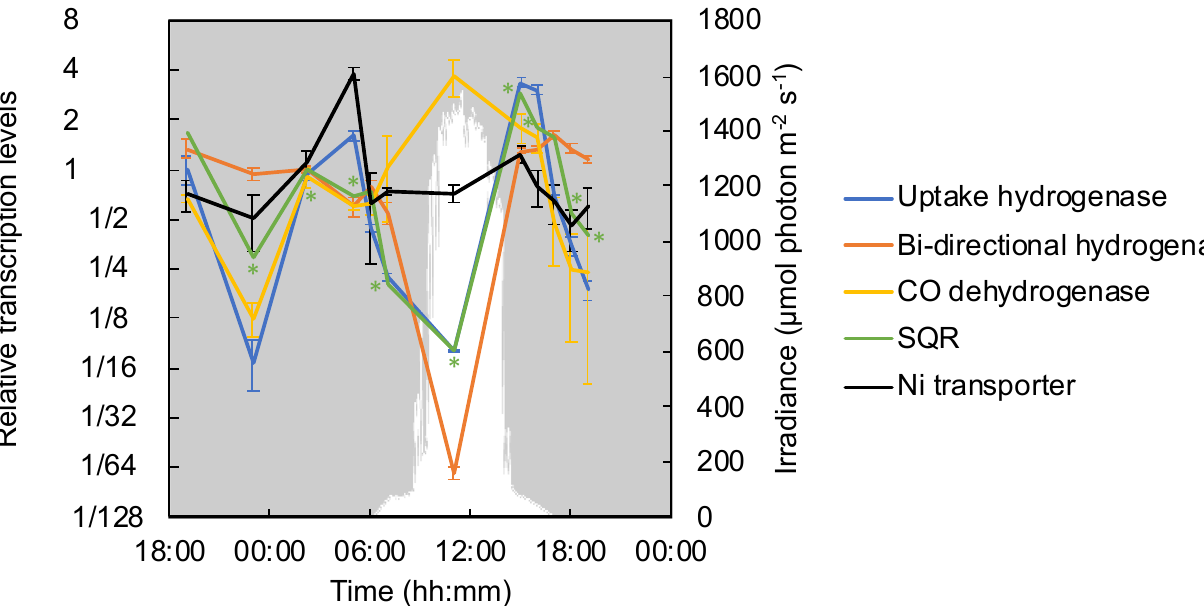
Figure 7. Relative transcription levels of genes encoding hydrogenases, sulfide:quinone oxidoreductase and nickel transporter in cyanobacterial mats. The mean values of the relative transcription levels for type-I uptake Ni-Fe hydrogenase genes hydAB (Cagg_0470–0471, blue line), bi-directional Ni-Fe hydrogenase genes homologous to frhA , frhG , hoxU , nuoF and hoxE (Cagg_2476–2480, orange line), carbon monoxide (CO) dehydrogenase genes coxGSML (Cagg_0971–0974, gray line), and nickel transporter genes (Cagg_1273–1276, light blue line) are shown with standard deviations. The relative transcription levels of the type-II sulfide:quinone oxidoreductase gene ( sqr , Cagg_0045) are represented by the black line. The downwelling photon irradiance (PAR; 400–700 nm) is indicated in white . The asterisk indicates the transcription of a particular gene corresponding to the color in a timepoint differed significantly from that in the previous timepoint.